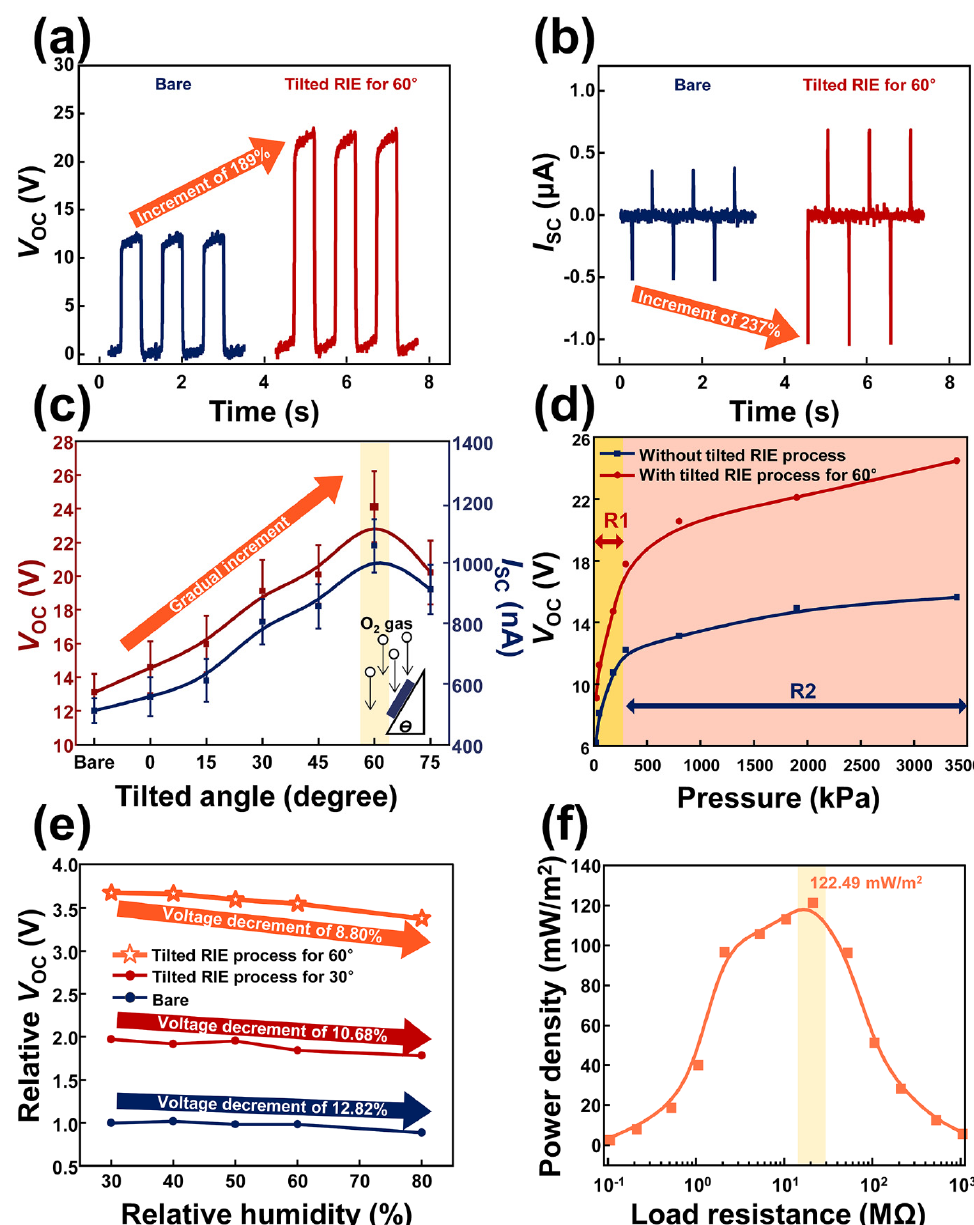
Figure 2. Electrical output generated from the TSR. ( a ) Open − circuit voltage and ( b ) short − circuit current generated from the TSR-B and TSR-T60. ( c ) Electrical output generated from the TSR according to the tilted angle. ( d ) Pressure sensitivity of the TSR − B and TSR − T60. ( e ) The relative open − circuit voltage according to the relative humidity. ( f ) Output power density with the various load resistances.